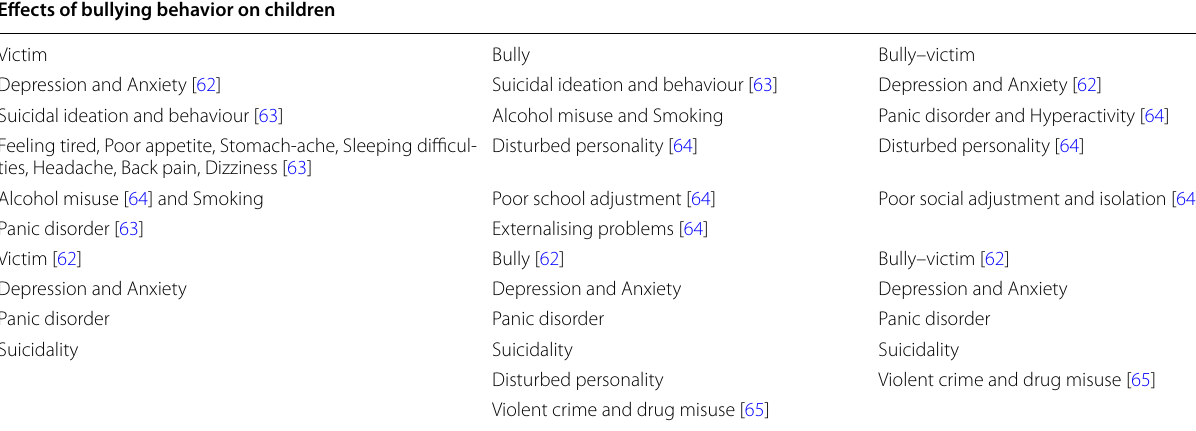
Table 3 The effect of bullying on children versus